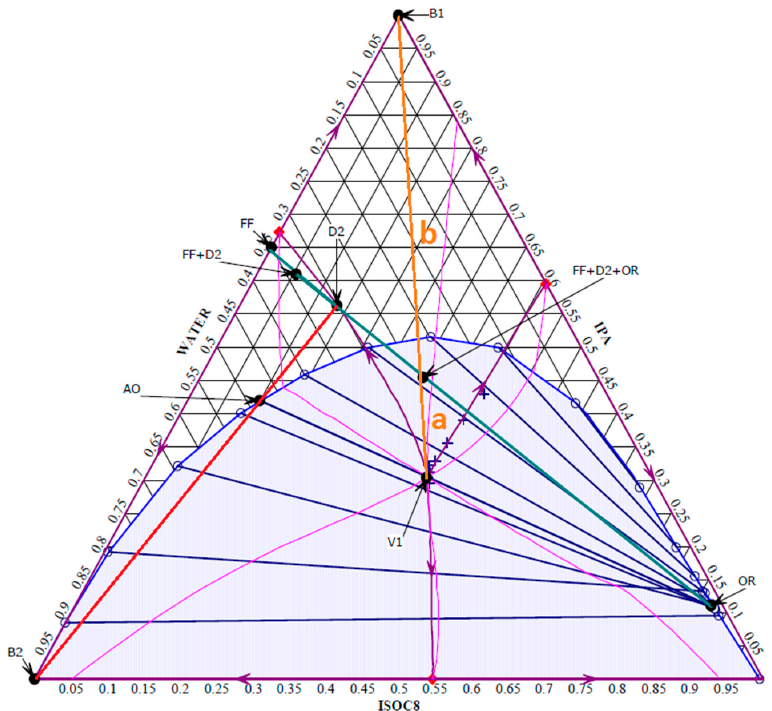
Figure 7. Ternary map at 1 atm for the system 2-propanol (IPA) + water (WATER) + isooctane (ISOC8), showing the points corresponding to the streams involved in the process shown in Figure 1, the material balance line for the HAD column (in orange), segments a and b for the calculation of the V1 flowrate (Equation (1)), and the material balance line for the recovery column (in red). Additional papers can be considered in order to compare the various candidate en- trainers [30,33,37,44,69]. In particular, with reference to what was reported by Gomis, Pienaar and their co-workers [30,33,44], the comparison of solvent performances should be based on the slope of the tie line passing through the heteroazeotropic point. As a mat- ter of fact, the efficiency of the process is improved when the amount of water eliminated in the decanter of the heterogeneous azeotropic distillation column is greater. Therefore, by considering that the vapor stream exiting the top of the column is close to the hetero- azeotropic point, the composition of the aqueous phase of the tie line containing the het- eroazeotrope is related to the amount of water eliminated after condensation and decanta- tion: when the water content of the aqueous phase is lower, a larger quantity of all of the components needs to be recirculated within the system (OR stream), with a consequent increase in the operating costs. Thus, by examining the ternary maps shown in Figures 2– 4, it can be noticed that the water content in the case of benzene as an entrainer is much higher (ca. 90% mol) than in the case of cyclohexane (ca. 60% mol) or isooctane (ca. 58% mol). Consequently, benzene can be regarded as the best entrainer for the separation of the 2-propanol + water mixture, whilst, with reference to cyclohexane and isooctane, re- markable differences are not found. The analysis carried out with the aid of the ternary maps allows the observation that benzene is the most appropriate entrainer as far as the HAD process is concerned for the